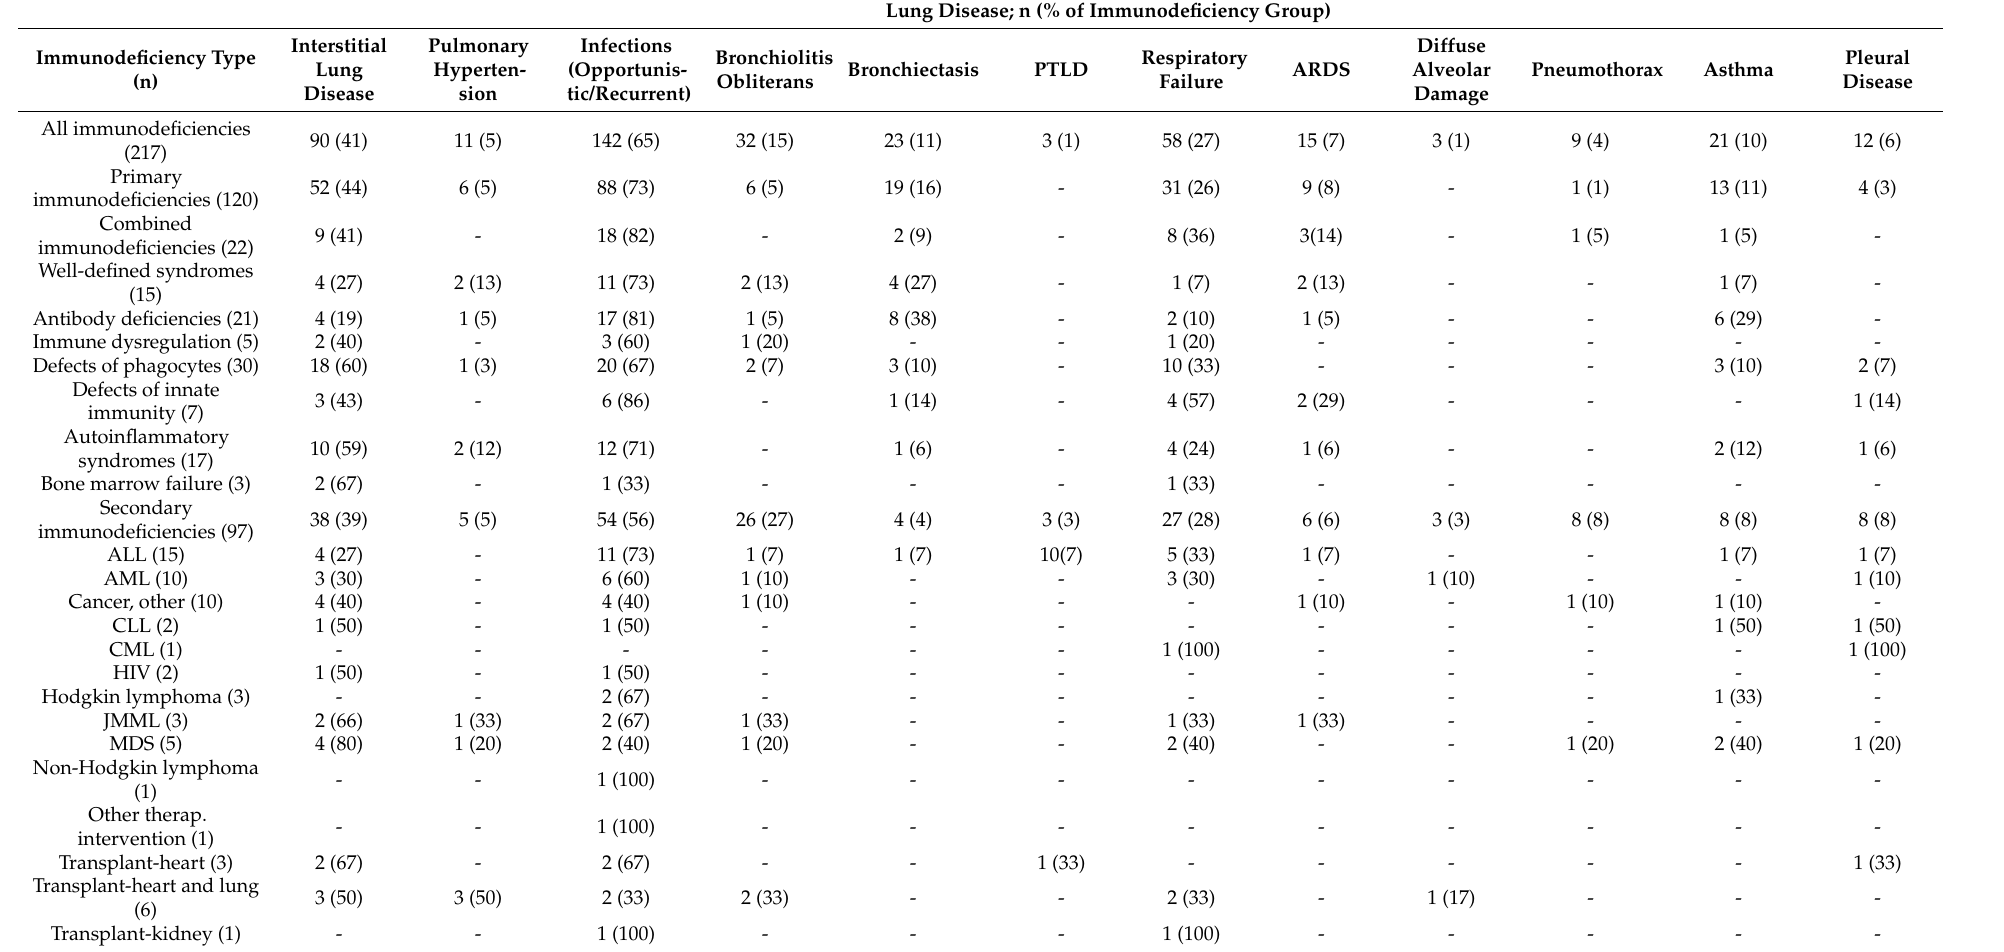
Table 2. Immunodeficiency types and associated lung